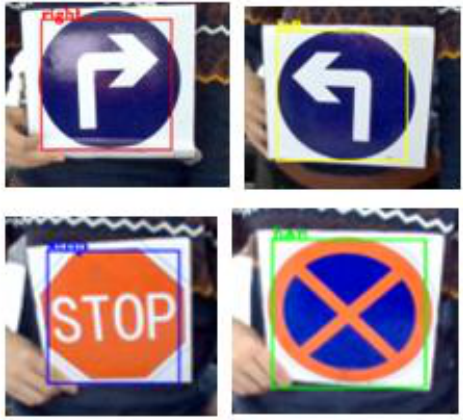
Figure 14. Identification effect of road signs.